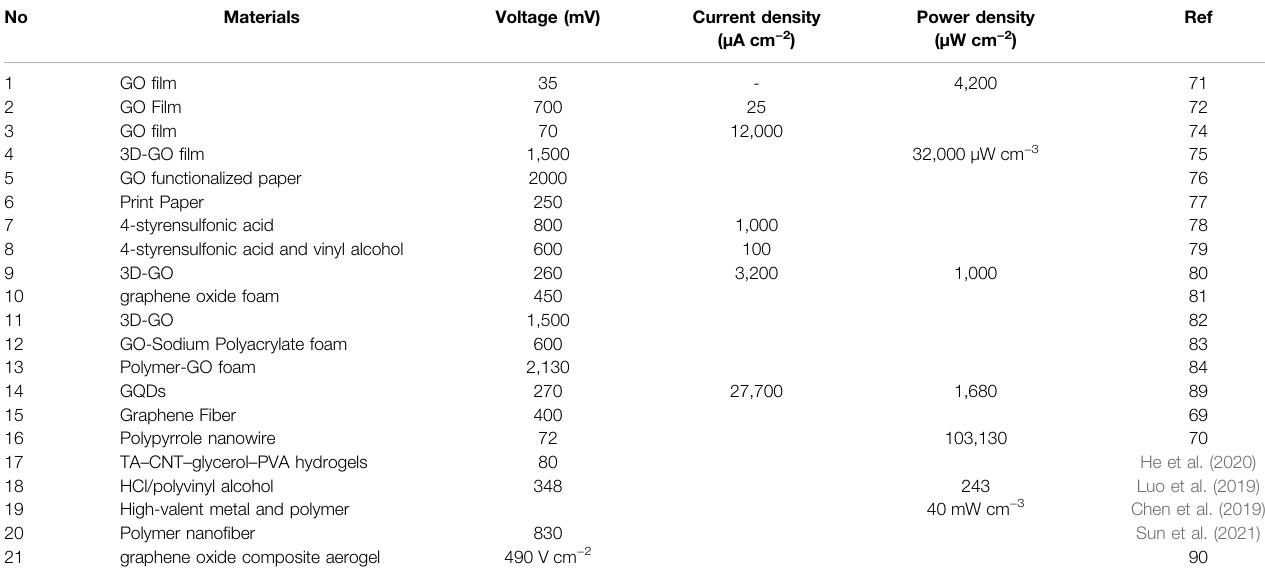
TABLE 1 | Summary of materials used to construct MEG